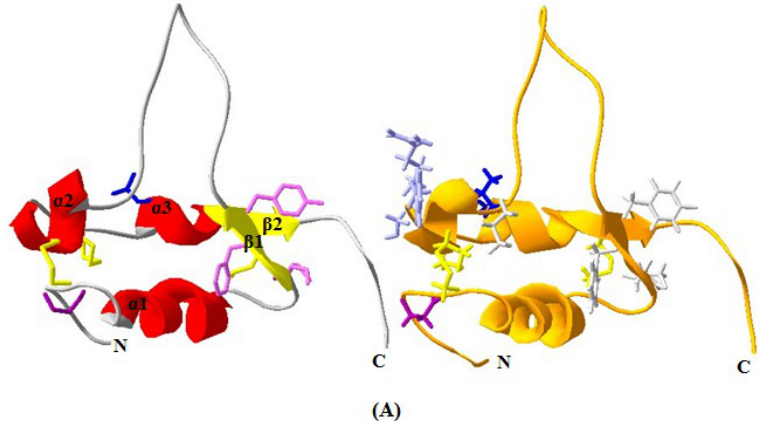
Figure 6. Predicted 3D structure model of yak IGF2 and the mainly chain interface structure. The 3D structure model was predicted by Swiss-model server. Left: yak IGF2, right: human IGF2. ( A ) Each chain contains 3 helixes. Binding sites were shown as rodlike molecules for yak IGFBP (modena), yak IGFBP and IGF-receptor and insulin-receptor (mauve) and yak IGF-receptor (blue); human IGFBP (modena), type 1 human IGF-receptor and insulin-receptor (white), type 2 human IGF receptor and IGFBP (French grey), human IGF-receptor (blue); ( B ) The view of IGF2 reveals three disulfide bonds (yellow, rod-like) which stabilize the fold; and ( C ) The mainly chain have four domain which B-domain (yellow), C-domain (green), A-domain (cyan) and D-domain